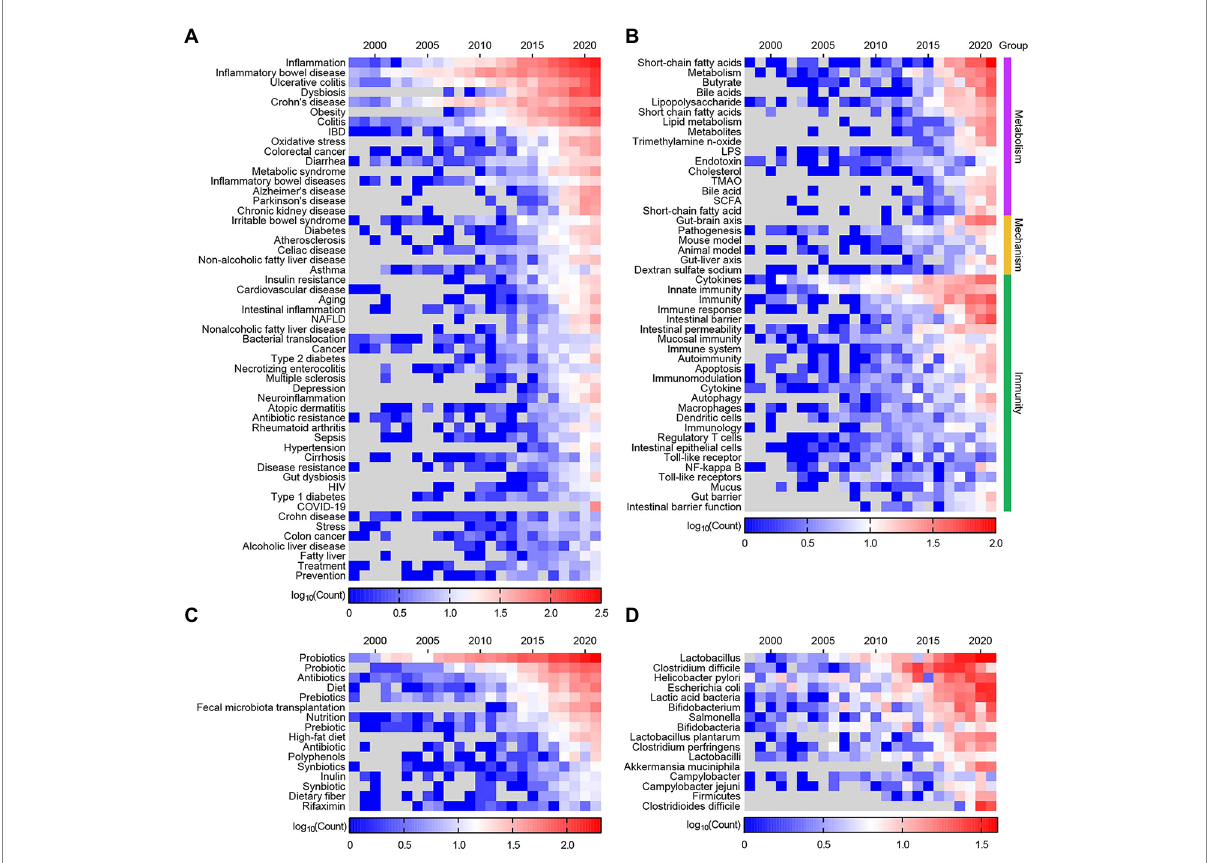
FIGURE 2 Heatmap of the top 200 keywords by frequency from articles published in 1998–2021. (A) The keywords related to “Diseases/Conditions.” (B) The keywords related to “Immunity,” “Mechanism,” and “Metabolism.” (C) The keywords related to “Intervention.” (D) The keywords related to